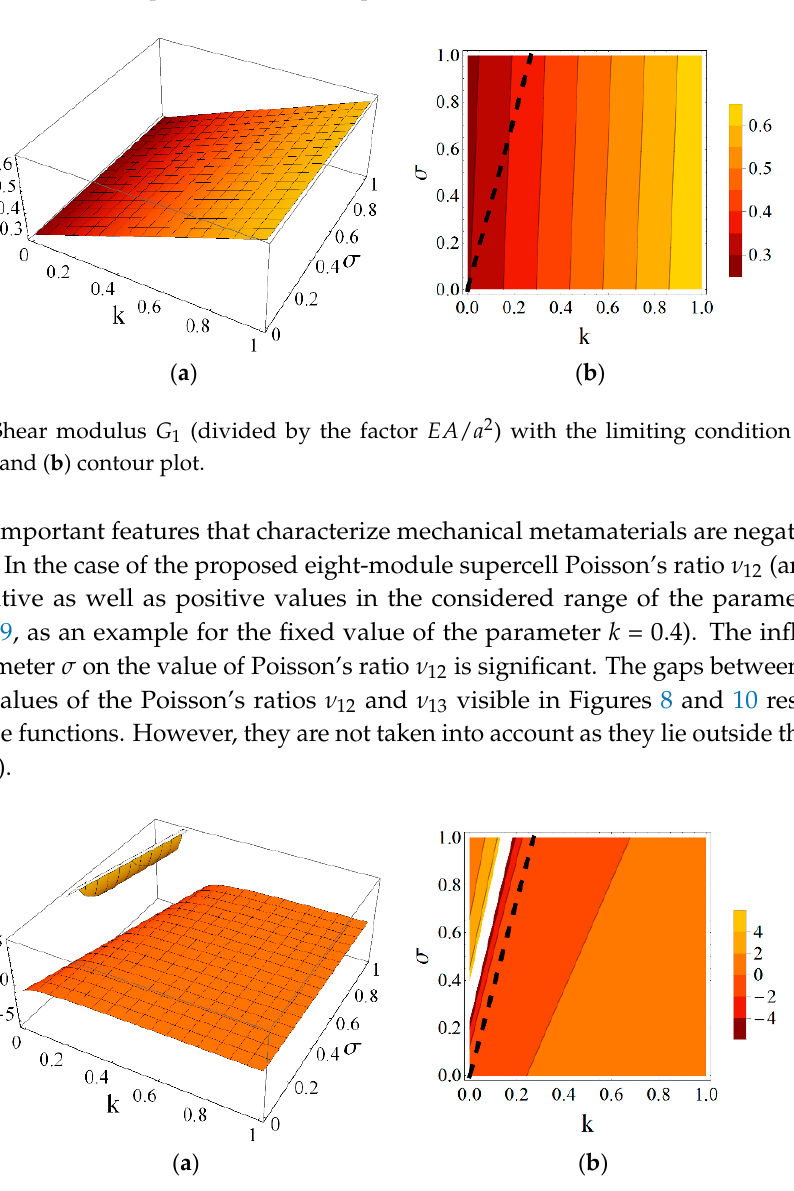
: ( a ) 3D plot; and ( b ) contour plot.